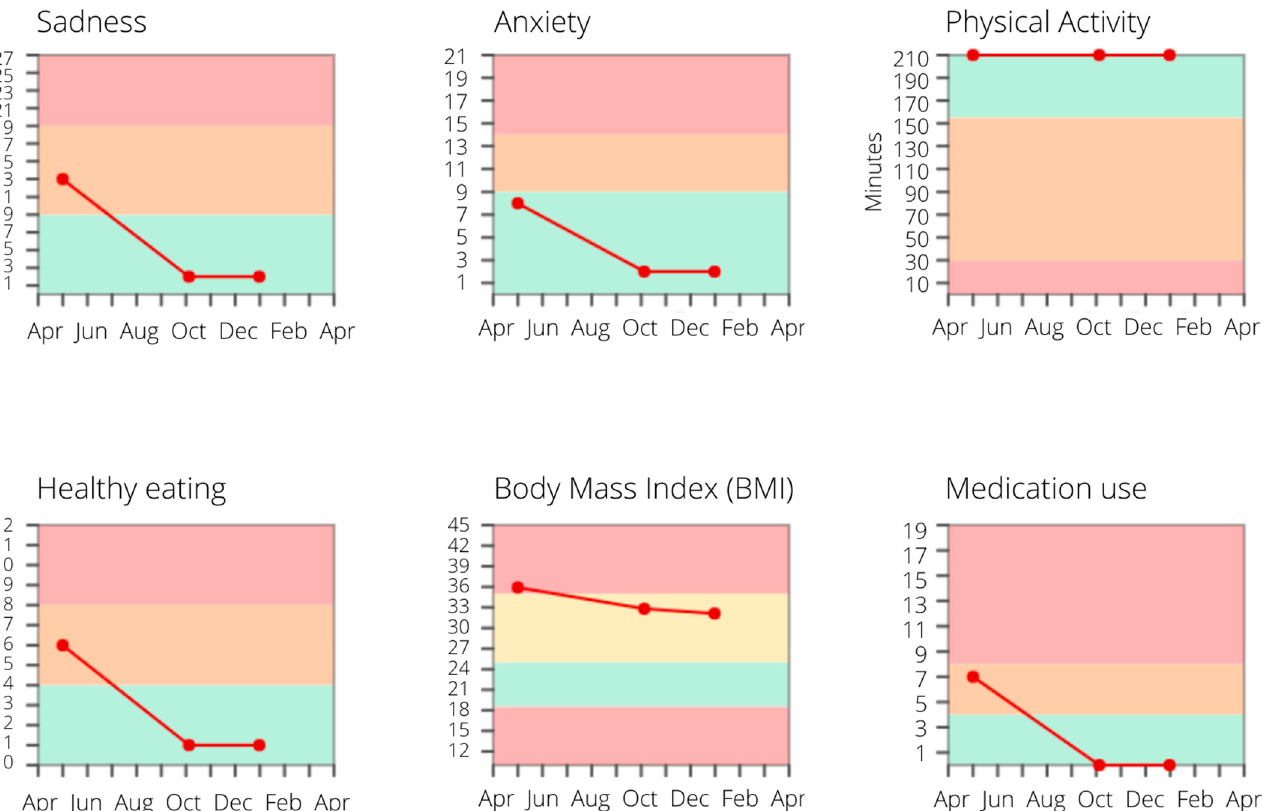
Figure 7. An example of monitor charts. Post ‐ treatment, this patient shows major improvements in depressive and anxiety symptoms, as well as in dietary and medication adherence, which are maintained at follow ‐ up.